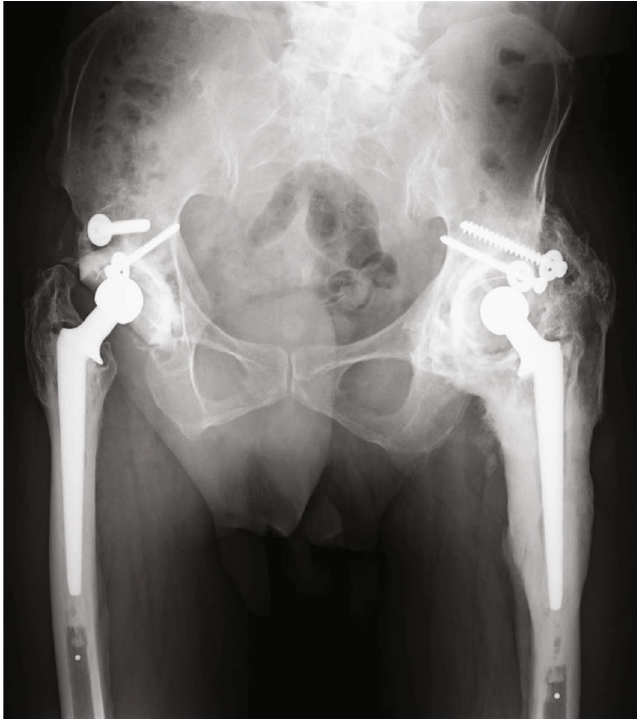
Figure 1: Plain radiograph obtained at the initial visit of a 78-year-old man, showing severe heterotopic ossi fi cation around the left hip